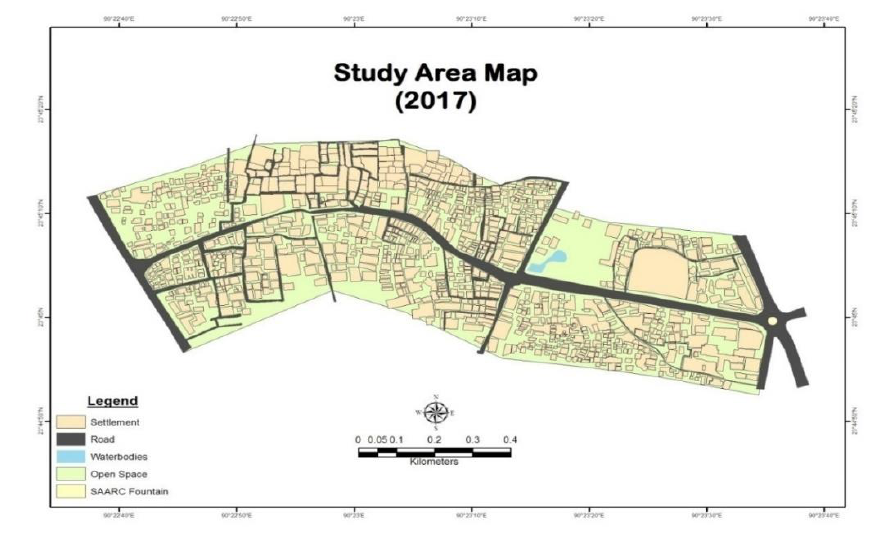
Figure 2. The Trend of the Capitalization of the Physical Environment in Panthapath,